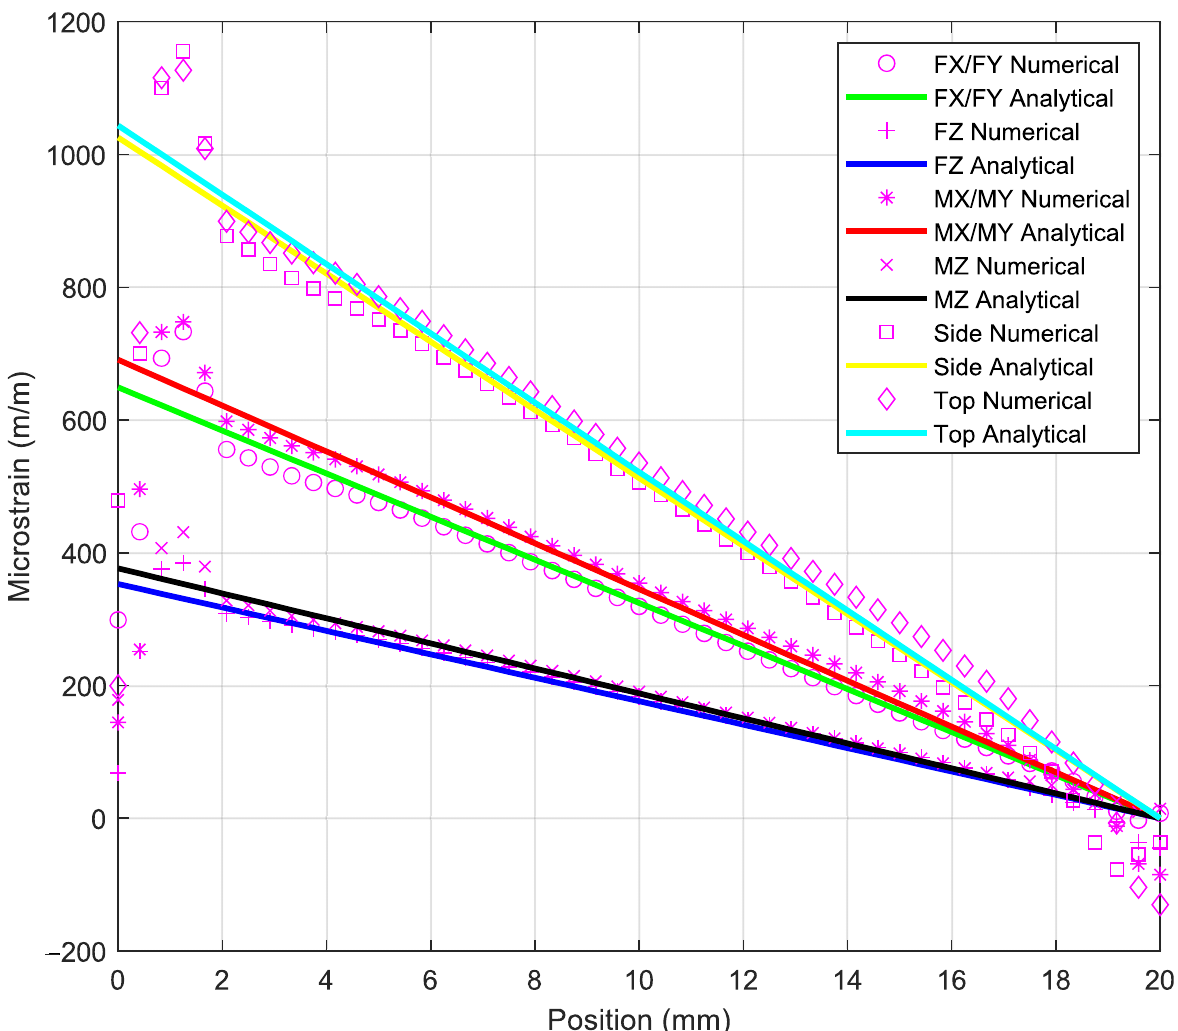
Figure 7. Normal strain analysis on the beam of the elastic body: numerical vs. analytical.